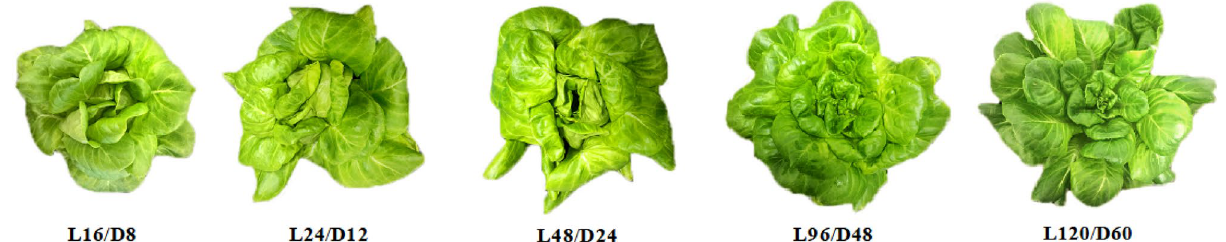
Figure 2. The morphology of lettuce exposed to different L/D cycle treatments of RB. L/D—light/dark. L16/ D8—16 h light/8 h dark (as control), L24/D12—24 h light/12 h dark, L48/D24—48 h light/24 h dark, L96/